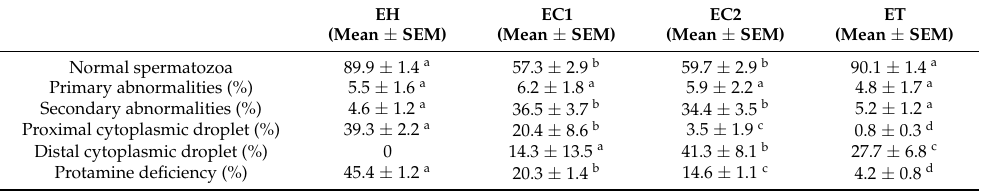
Table 3. Sperm abnormalities and sperm protamine deficiency (indirectly estimated by chromomycin A3) reported as mean ± standard error of the mean (SEM) in the different epididymal tracts of the